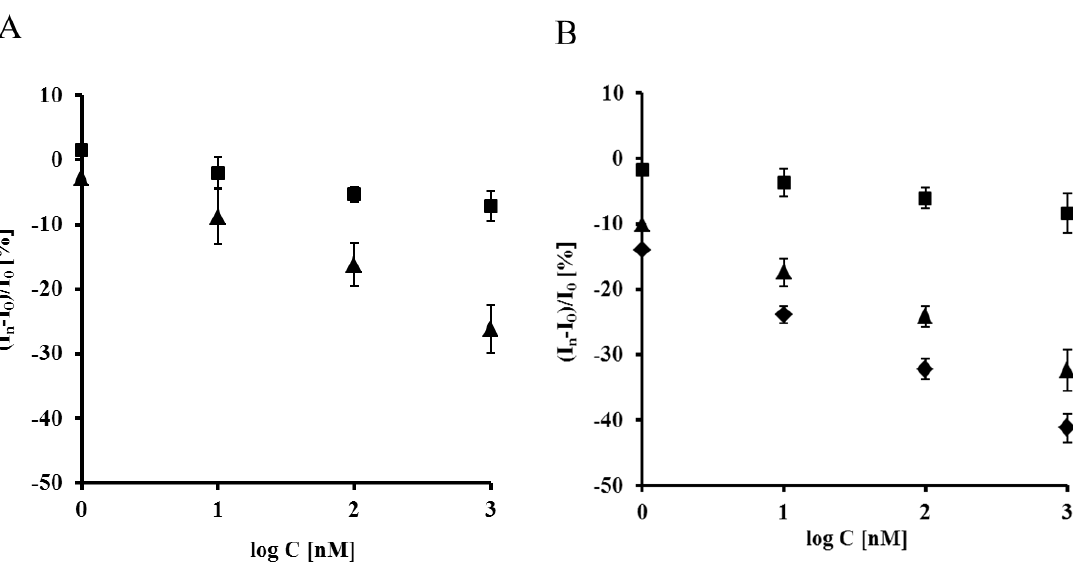
Figure 8. The relationship of relative Cu(II) redox current decrease vs. concentration of: ( A ) Aβ measured with electrodes: Au/NAC/DPTA–Cu(II)–His –RAGE V natural domain 16–23’ 6 ( ▲ )-in TRSI buffer; Au/NAC/DPTA–Cu(II)–His –RAGE V mutated domain ( ■ )-in TRIS 6 buffer (n = 7); ( B ) Aβ measured with electrodes: Au/NAC/DPTA–Cu(II)–His –RAGE 1–40 6 VC1 natural domain ( ▲ )-in TRIS buffer, ( ♦ )-in the presence of diluted human plasma; Au/NAC/DPTA–Cu(II)–His –RAGE VC1 mutated domain ( ■ )-in TRIS buffer (n = 6